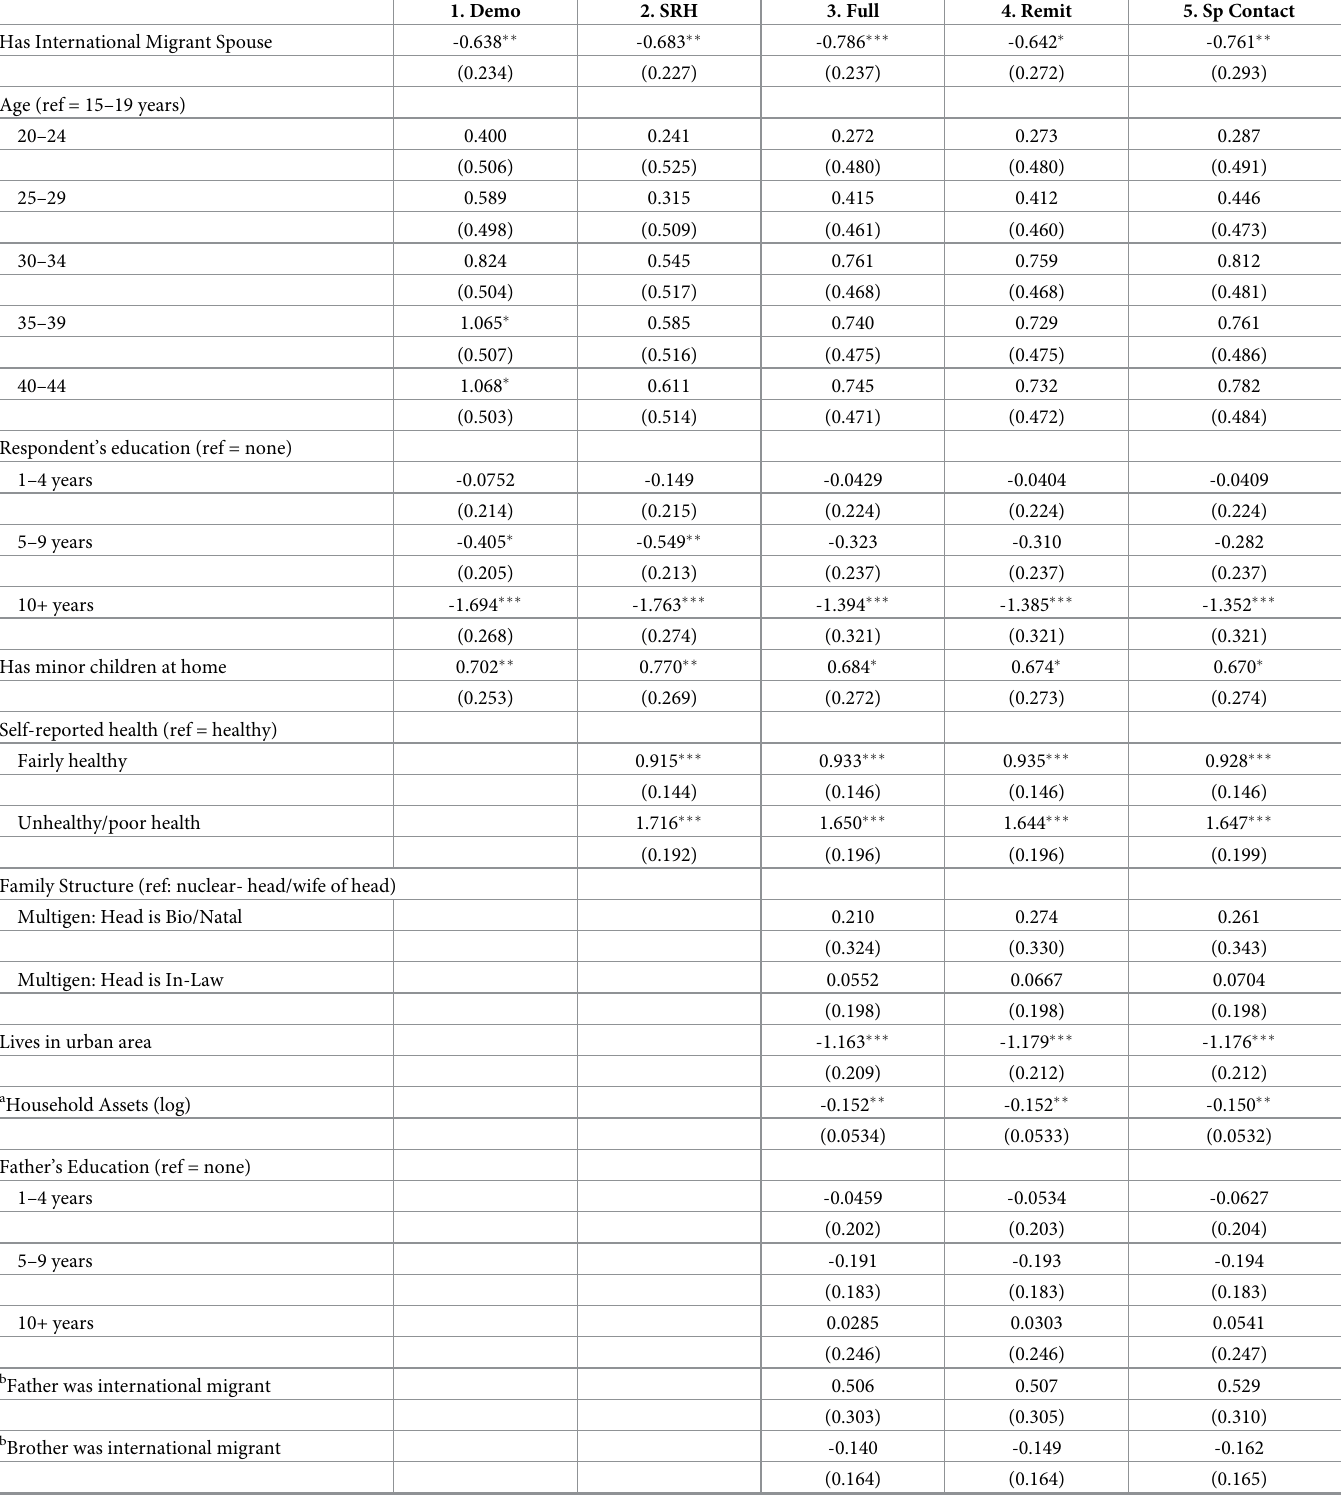
Table 3. Multivariate analysis of characteristics associated with not accessing needed